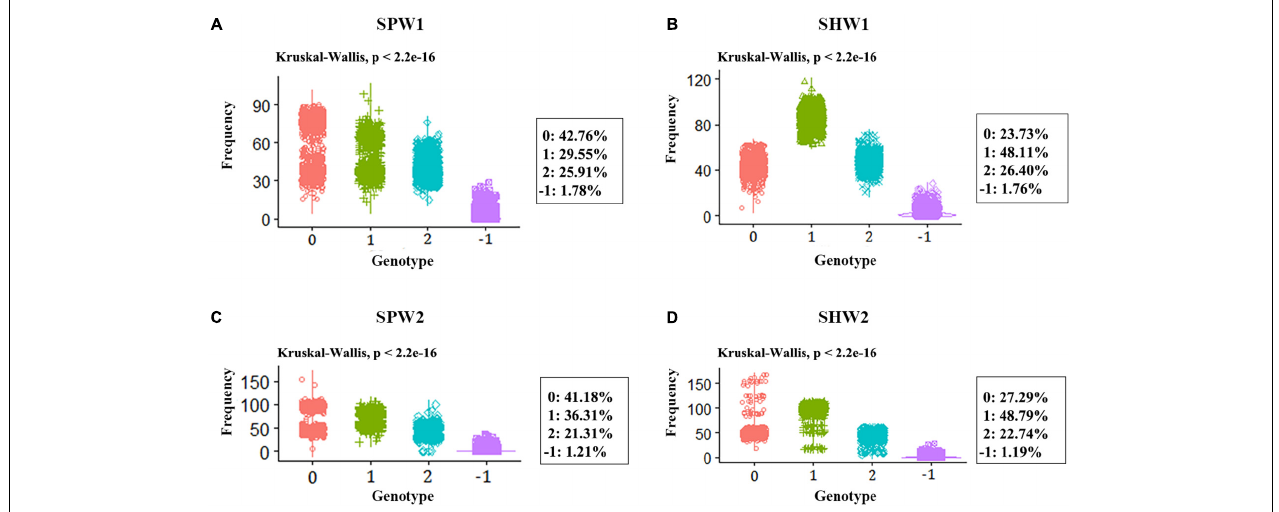
FIGURE 4 | Statistical of genotype frequency in pentaploid and hexaploid populations. 0, genotype frequency of the female parent; 1, genotype frequency of the heterozygous; 2, genotype frequency of the male parent; -1, missing rate. (A) SPW1 population. (B) SHW1 population. (C) SPW2 population. (D) SHW2